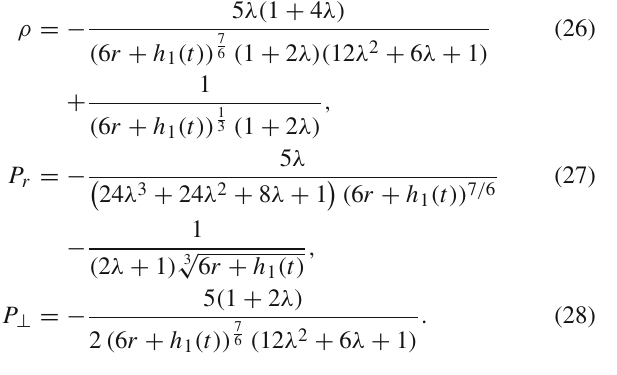
Fig. 1 The variation of ρ with respect to r for the various values of λ and h 1 ( t ) =